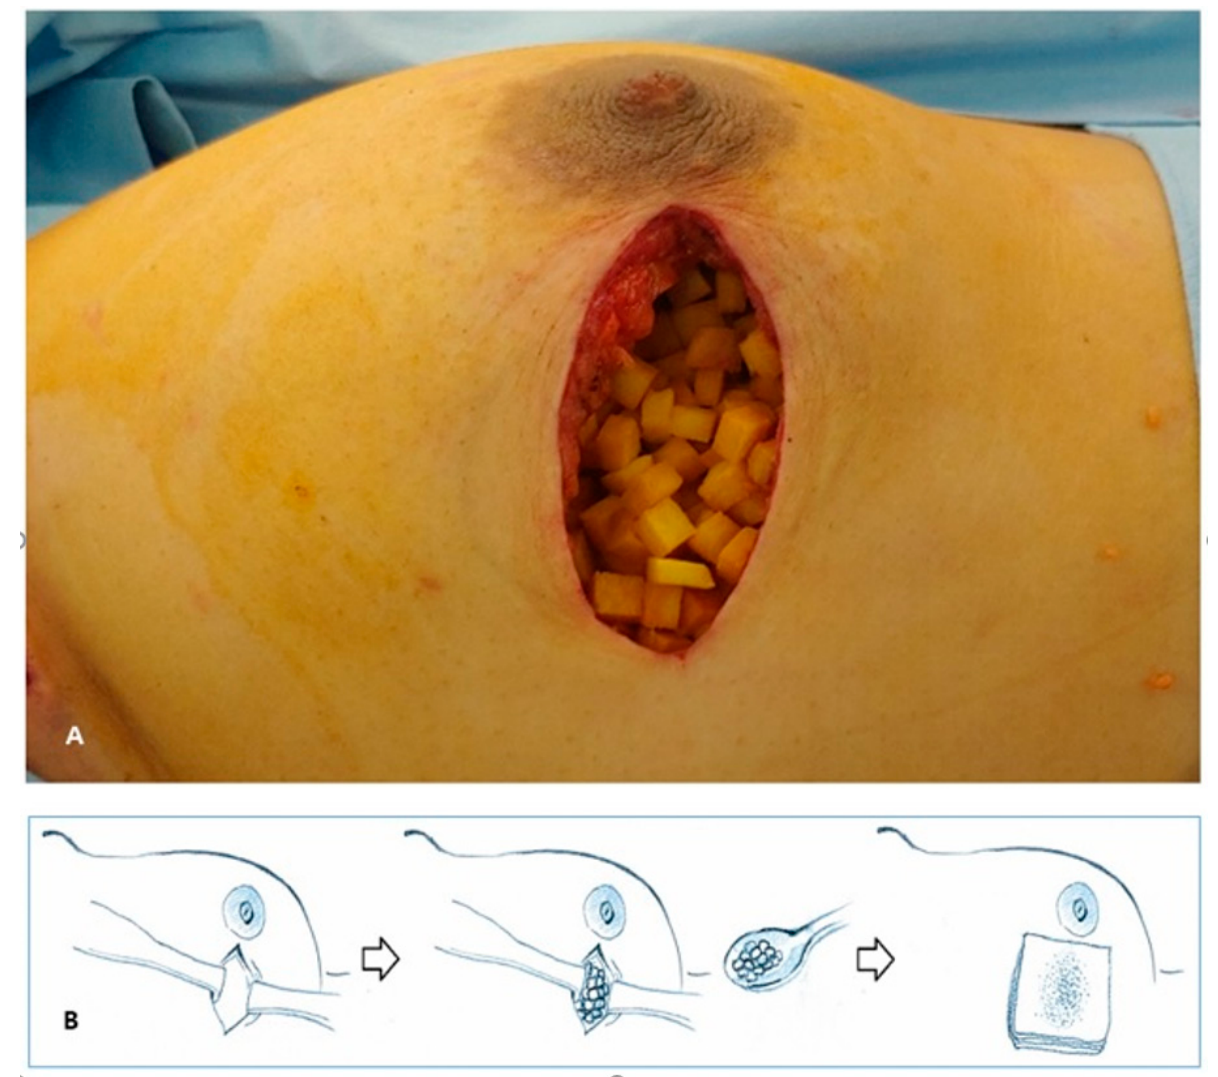
Figure 3. How to insert the ADM. ( A ) The ADM soaked in betadine solution was inserted at the surgical cavity. ( B ) After ADM insertion, compression with gauze was needed for removal of remnant betadine solution and discharge. ADM, acellular dermal matrix.